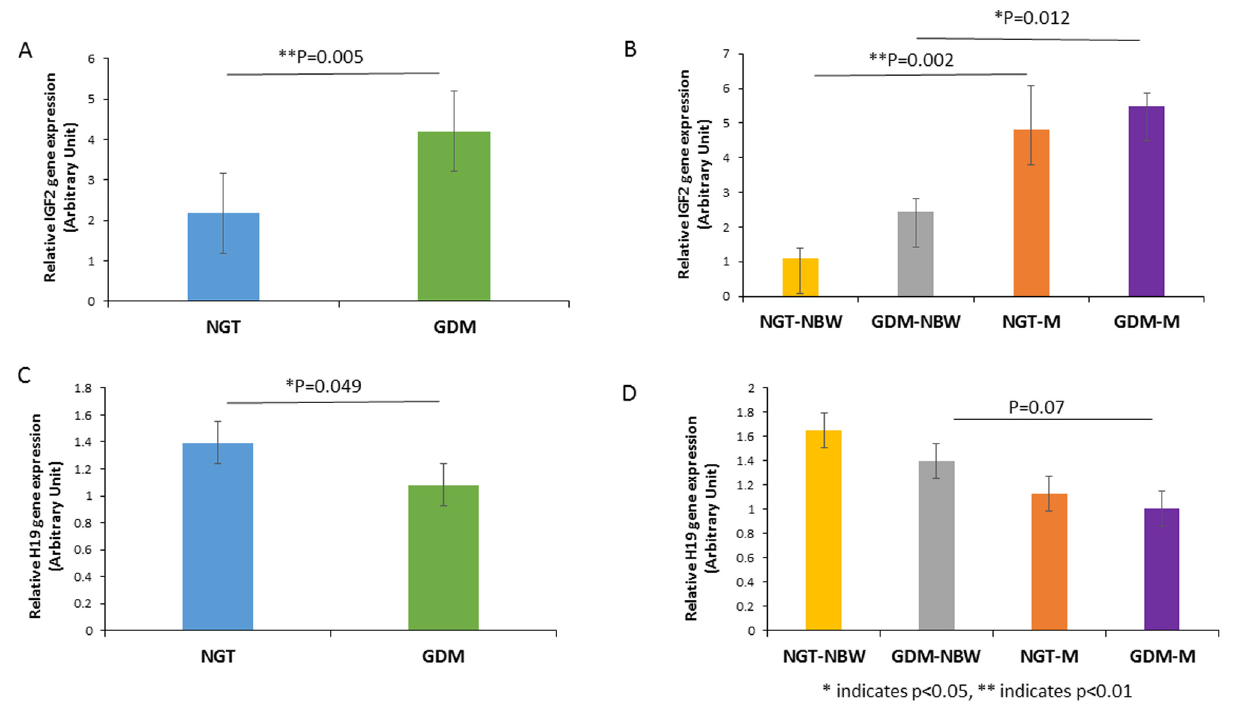
Fig 2. IGF2/H19 Expression in Umbilical Cord Blood. A, The expression of IGF2 in umbilical cord blood was significantly higher in GDM group than that in NGT group. (B) The expression of IGF2 in umbilical cord blood was significant higher in NGT-M group than that in NGT-NBW group. (C) The expression of H19 in umbilical cord blood was decreased significantly in GDM group compared to the NGT group. (D) The expression of H19 in umbilical cord blood had a trend decreased in NGT-M group and GDM-M group compared with normal group. * indicates p < 0.05, ** indicates p < 0.01.